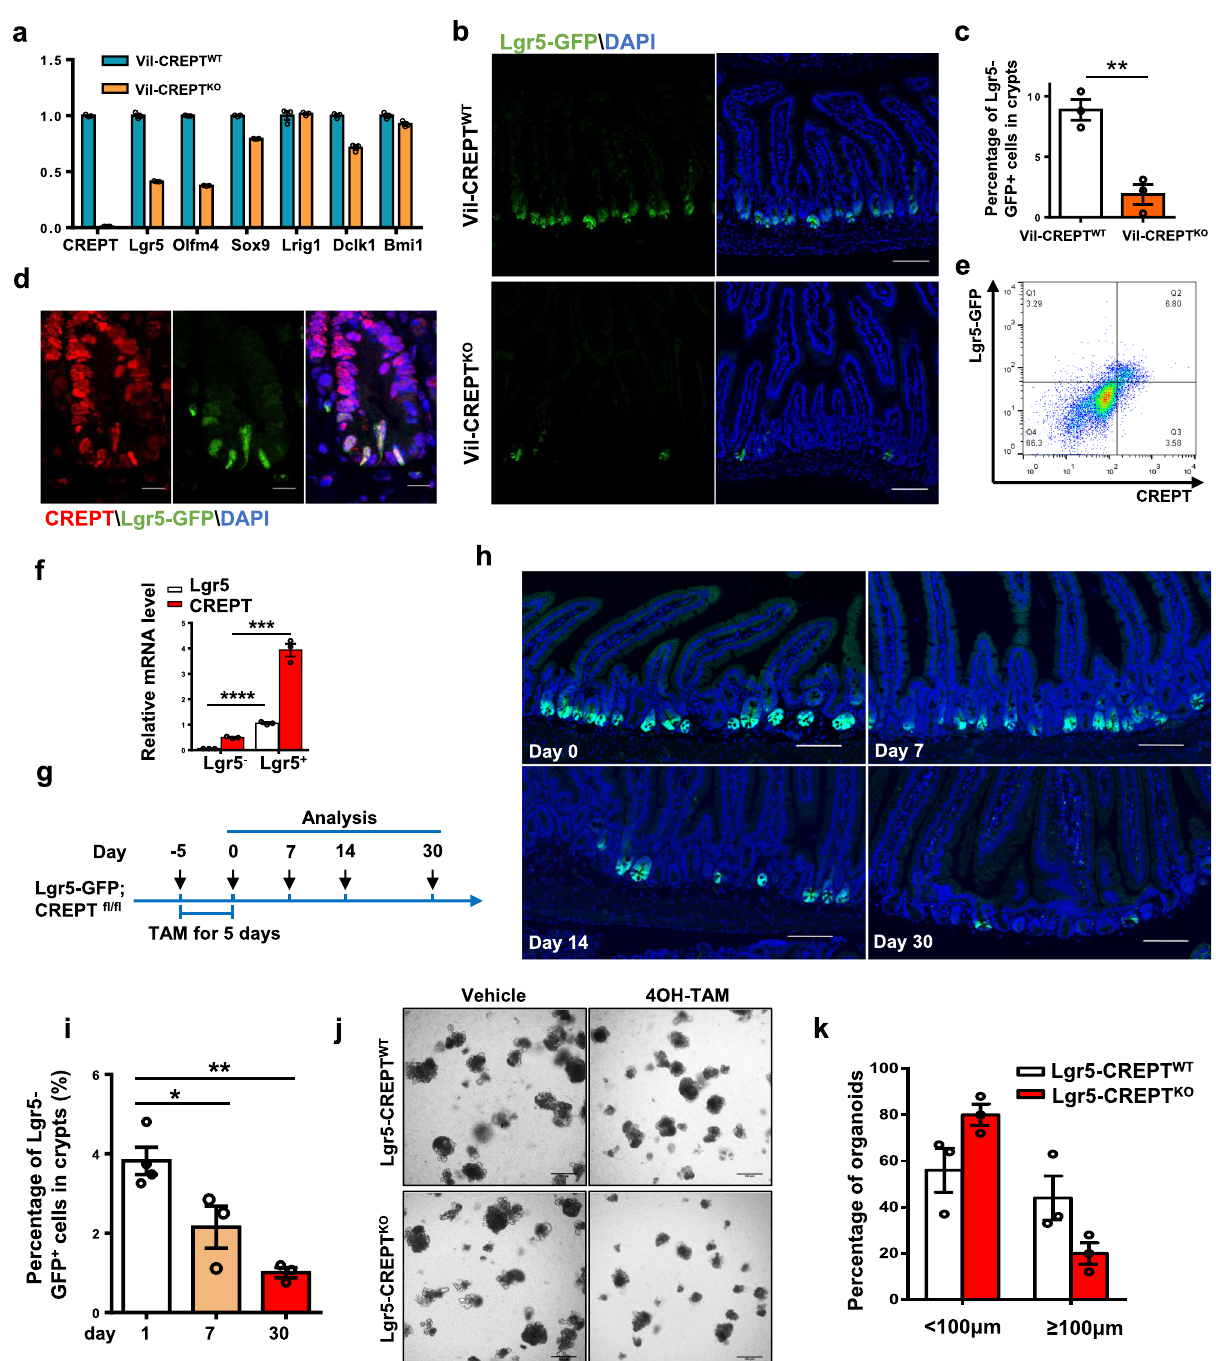
Fig. 2 CREPT deletion reduces the Lgr5 + cell number. a A quantitative RT – PCR analysis of the expressions of CBC and reserve stem cell markers in WT and Vil-CREPT KO crypt cells. b Representative images of Lgr5-GFP + cells in WT and Vil-CREPT KO intestines. c Quanti fi cation of Lgr5-GFP + cells in small intestines of WT and Vil-CREPT KO mice based on FACS analyses. n = 3 independent experiments. p = 0.0042. d Representative images of Lgr5 and CREPT staining in intestine crypts. e A FACS analysis of Lgr5 and CREPT stained cell populations. The population of crypts cells, which had the highest level of Lgr5, also expressed the largest amount of CREPT protein. f A quantitative RT-PCR analysis of Lgr5 and CREPT in sorted Lgr5-GFP + and Lgr5-GFP − cells. n = 3 independent experiments. p < 0.0001 (Lgr5 in Lgr5 − vs. Lgr5 + cells). p = 0.0002 (CREPT in Lgr5 − vs. Lgr5 + cells). g A schematic diagram showing the TAM treatment in Lgr5-GFP; CREPT fl / fl mice. h Representative images of Lgr5-GFP staining in intestines at indicated time post TAM treatment. i Percentage of Lgr5-GFP high cells in crypts at indicated time post TAM treatment by FACS analyses. p = 0.0393 (day 1 vs. day 7). p = 0.0011 (day 1 vs. day 30). j Representative images of WT and CREPT deleted organoid formation derived from Lgr5-GFP and Lgr5-GFP; CREPT fl / fl mice. k The numbers of WT and Lgr5-CREPT KO organoids showing <100 μ m and ≥ 100 μ m diameters. Images are representative of at least three independent experiments. Statistics data represent mean ± SEM. All p values were generated by 2-tailed Student ’ s t -test. Scale bars: 100 μ m ( b , h , j ), 10 μ m ( d ).